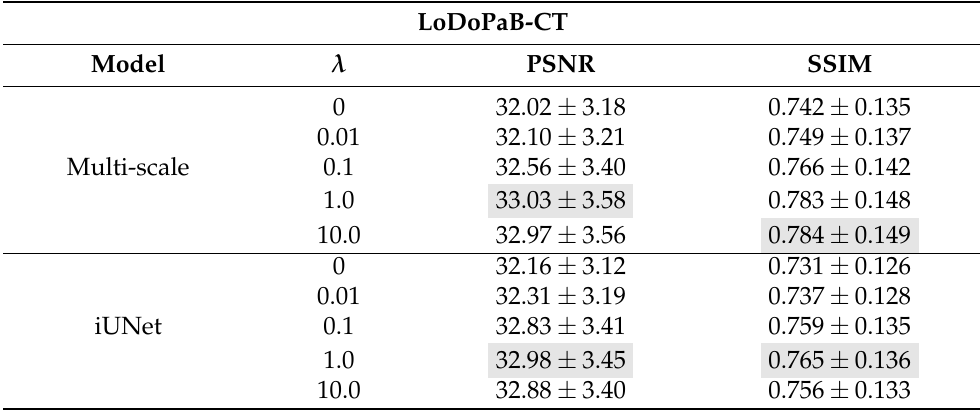
Table 4. Mean and standard deviation for sample refinement on LoDoPaB for the first 100 samples of the test set. Minimized Equation (22) for 100 iterations with a learning rate 1 × 10 − 4 . The initial ( z , y δ ) value was one sample from our model x 0 = T − 1 θ